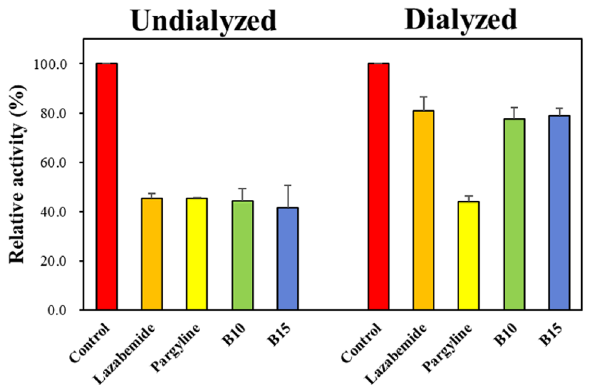
Figure 3. Recoveries of hMAO-B inhibitions by B10 and B15 using dialysis